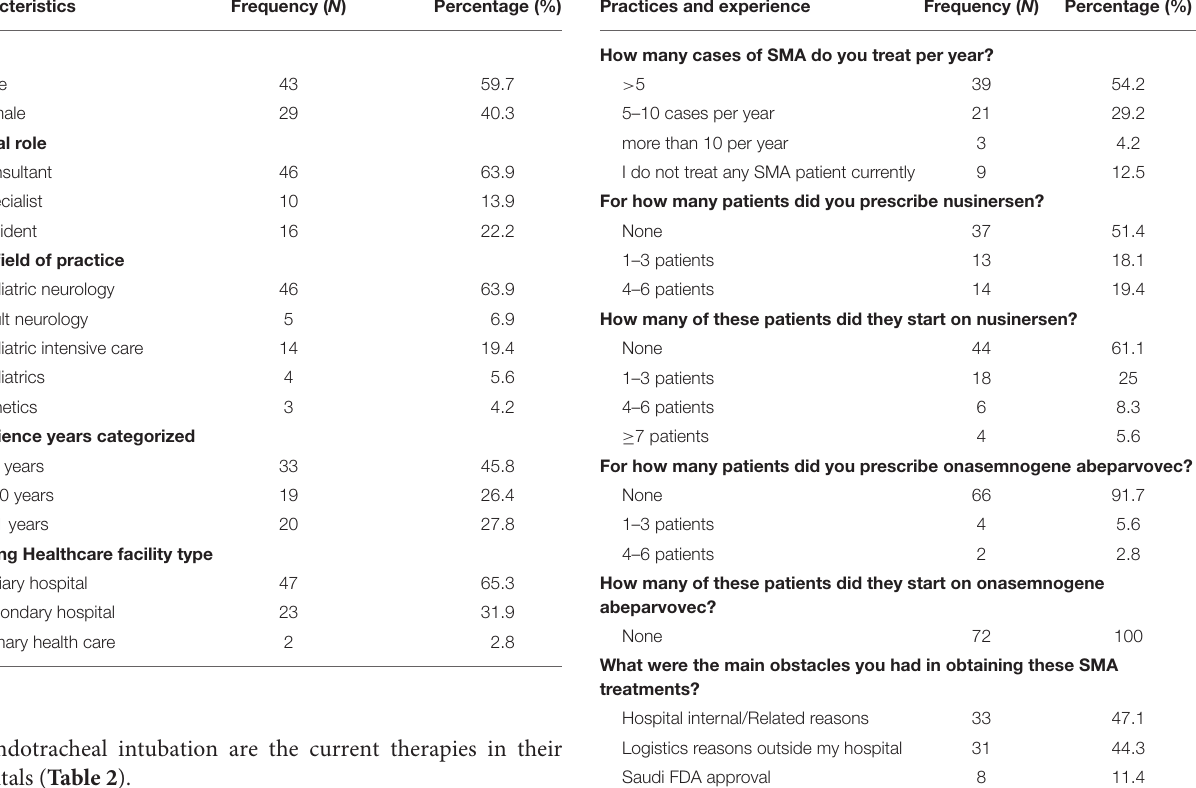
TABLE 1 | Responders’ sociodemographic and professional characteristics. Characteristics